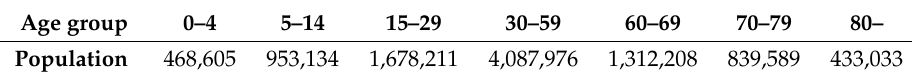
Table 2. Age groups of the Hungarian